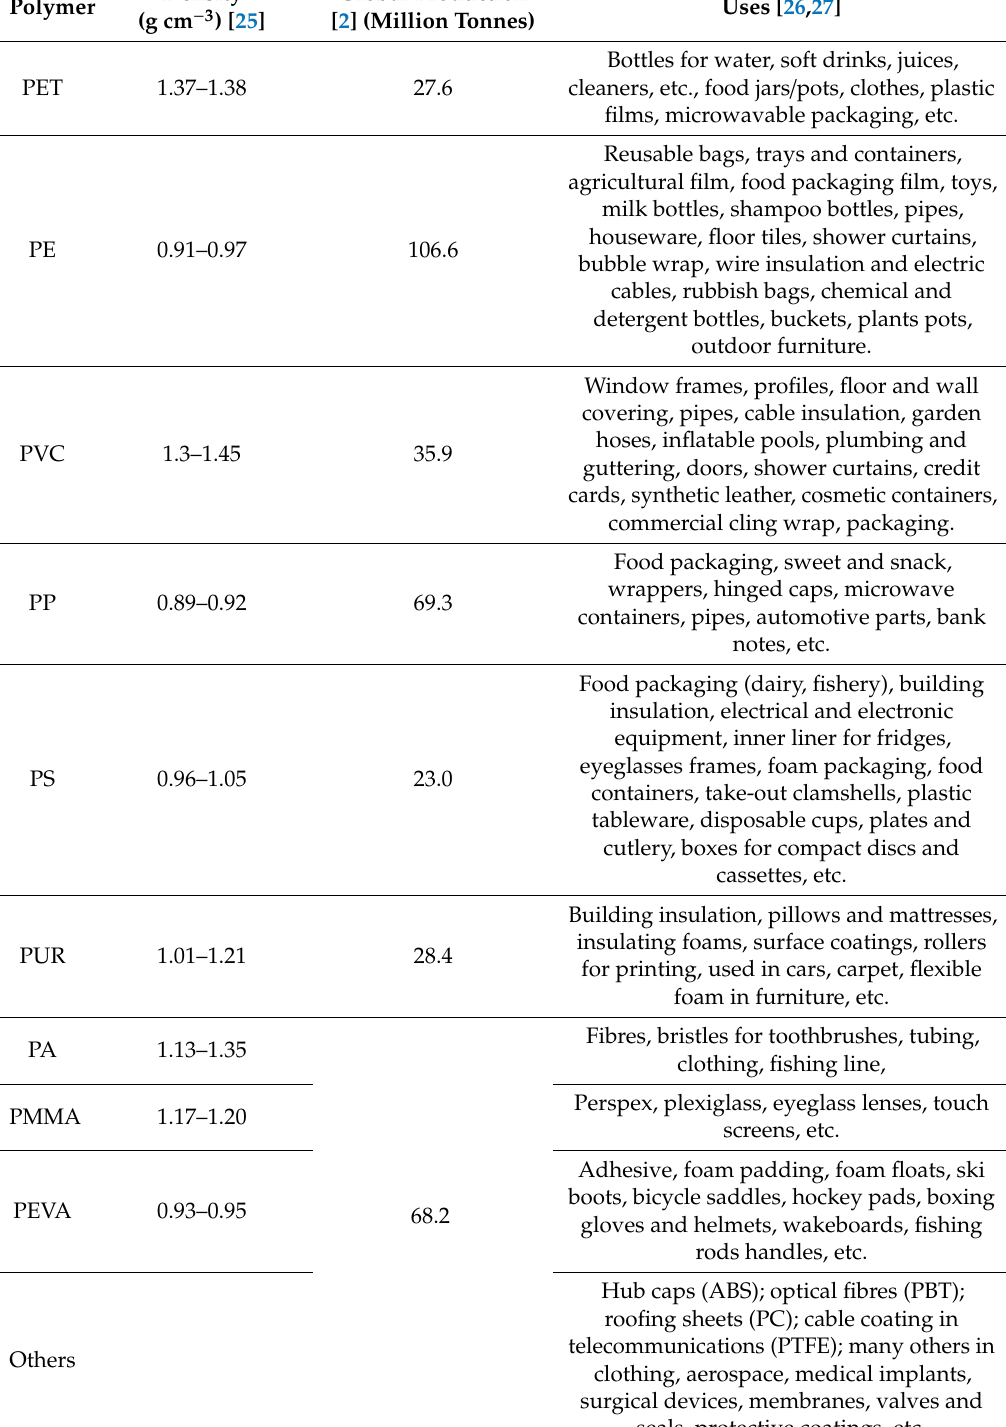
Table 2. Characteristics and uses of polymers identified as microplastics in freshwaters and estuaries.